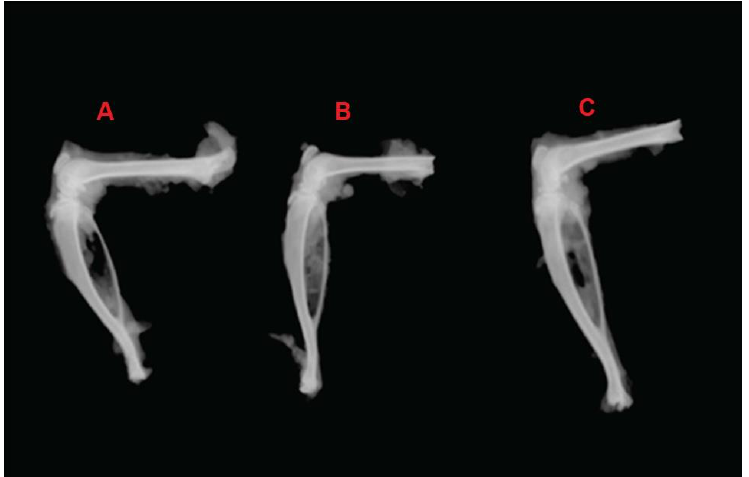
Figure 13. Radiographic analysis of the knees with the administration of the formulation. ( A ): FCA- induced arthritis, control group; ( B ): Methotrexate-loaded nanoemulsion; ( C ): marketed drug solu- tion.